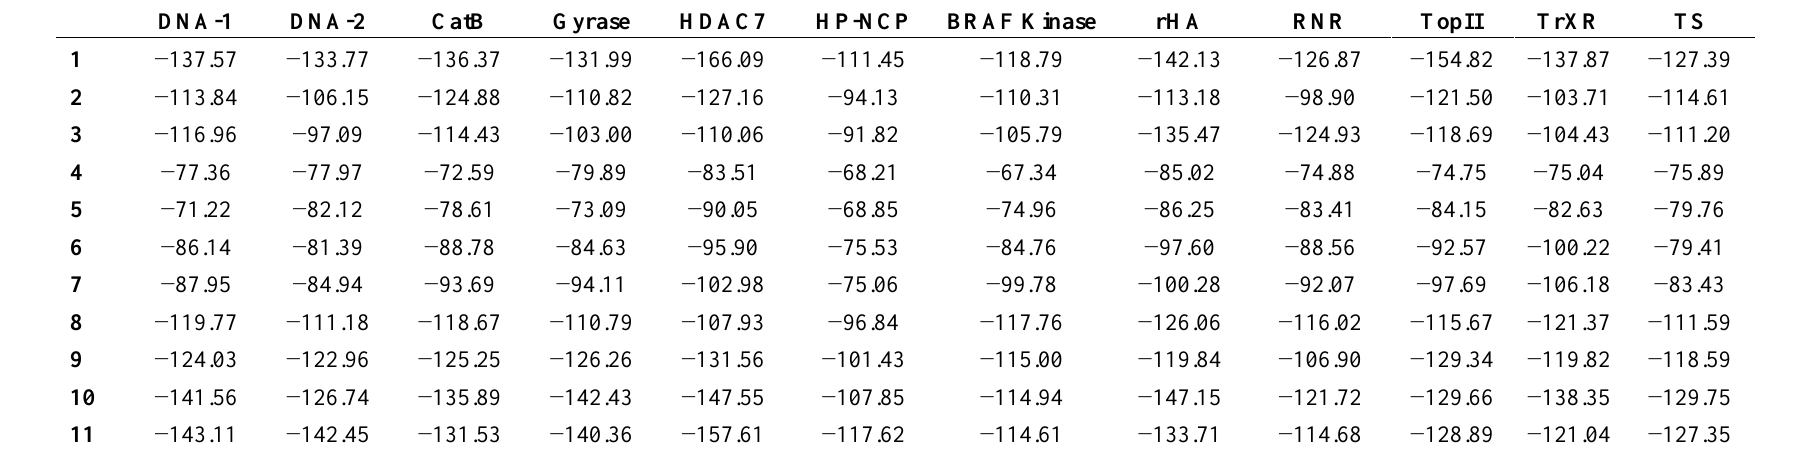
Table 4. The binding energy of the metallocompounds from the relaxed Molgro